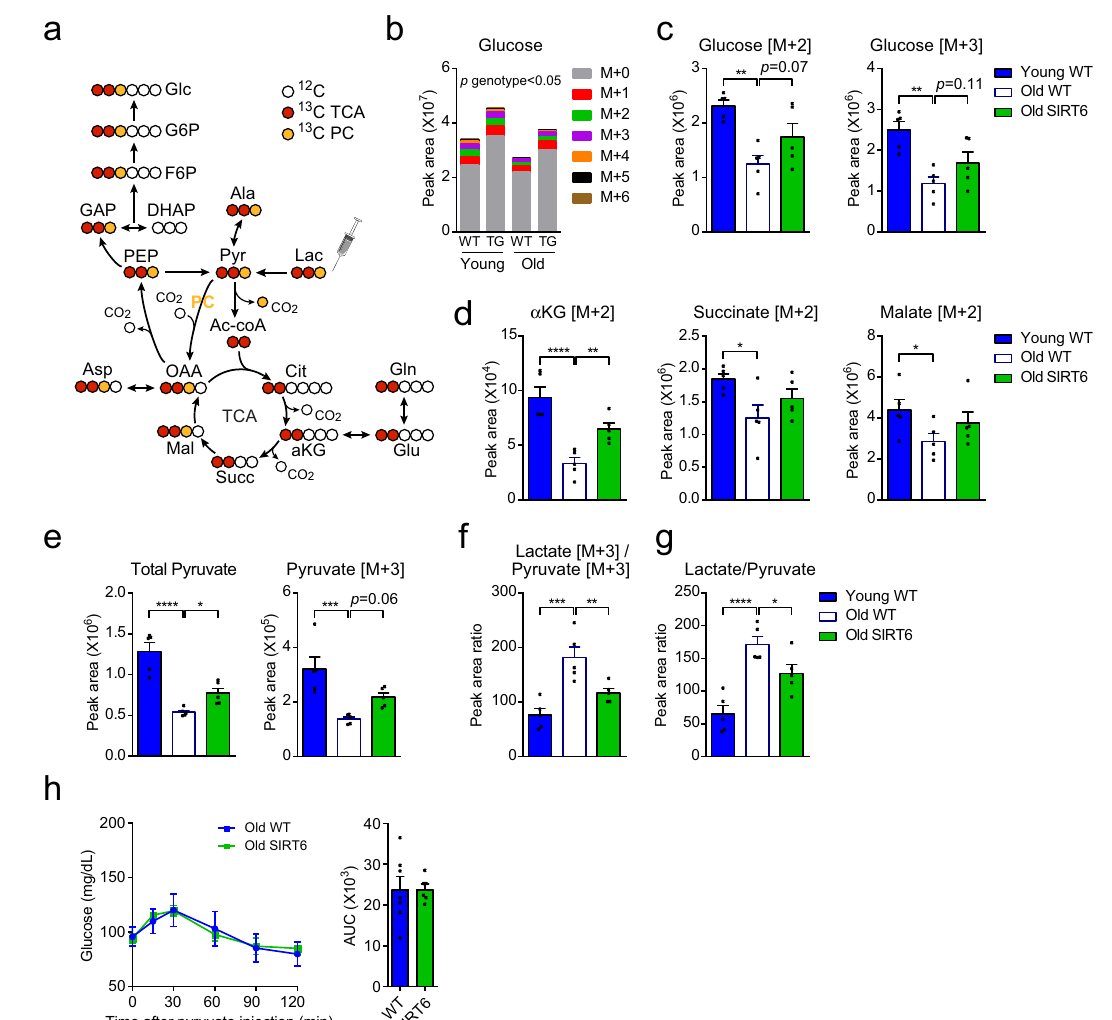
Fig. 6 SIRT6 restores the signi fi cant reduction in hepatic lactate oxidation and contribution to GNG at old age. a Schematic showing fates of lactate carbons following injection of [U- 13 C]-lactate, after one round of the TCA cycle or fl ux through pyruvate carboxylase (PC, Pyr → OAA). White balls, 12 C carbons. Colored balls, 13 C carbons. Red, carbon fl ux from lactate to glucose via the TCA cycle. Yellow, carbon fl ux from lactate to glucose via PC. b Hepatic glucose isotopologues, 15 min after [U- 13 C]-lactate injection. c – e , Relative abundance of hepatic glucose [M + 2] and glucose [M + 3] ( c ), the TCA cycle metabolites α KG [M + 2], succinate [M + 2] and malate [M + 2] ( d ), and total pyruvate and pyruvate [M + 3] ( e ) 15 min after [U- 13 C]-lactate injection. Metabolite peak area values were normalized to total ion count. f , g Hepatic lactate [M + 3] / pyruvate [M + 3] peak area ratio ( f ), and ratio of total liver metabolite levels of lactate/pyruvate ( g ) 15 min after [U- 13 C]-lactate injection. For ( b – g ), mice were at the ages of 5 – 7 months (young) and 20 – 24 months (old). n = 5 mice; bars represent mean ± SEM. One-way ANOVA with Fisher ’ s LSD method. Exact p -values are reported in the Source Data fi le. * p <